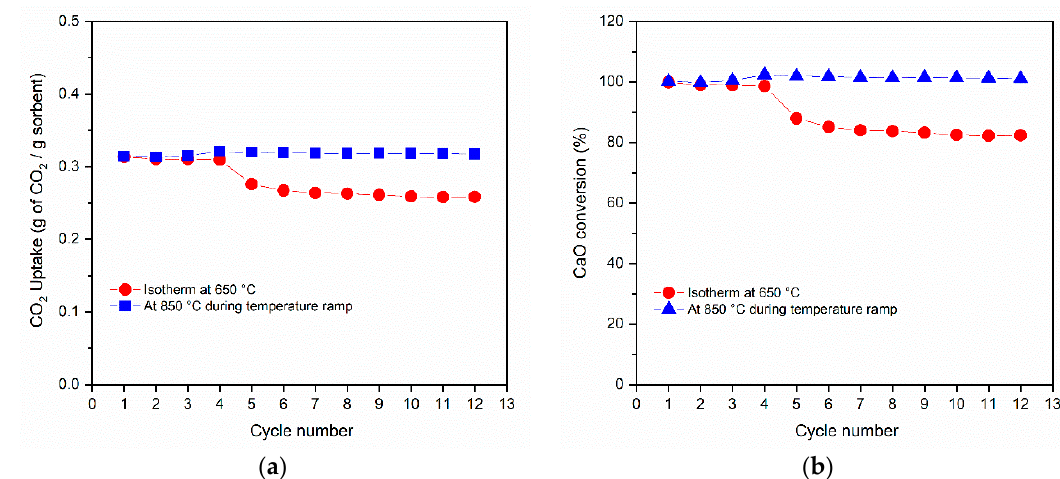
Figure 8. Stability and performance tests of CCZ40 sample under severe conditions showing the CO 2 uptake over 12 cycles ( a ) and the calculated CaO conversion ( b ) in the isotherm step at 650 °C (red) and at 850 °C during the temperature ramp up to 900 °C (blue).